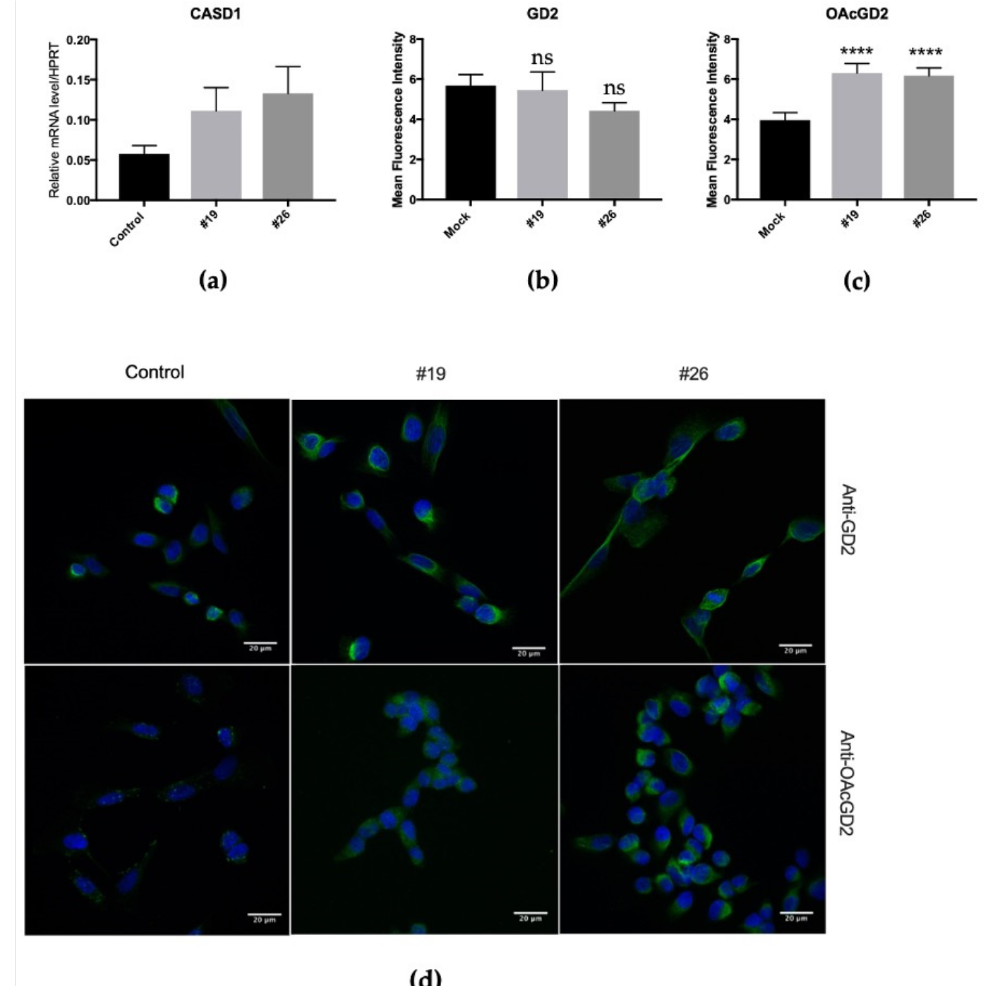
Figure 7. The expression of CASD1 mRNA and quantification of O AcGD2 and GD2 expression in SUM159PT CASD1+ clones. ( a ) RT-qPCR quantification of CASD1 gene expression in stably transfected and control SUM159PT cells ( n = 3). Results were normalized to HPRT mRNA expression. ( b ) Quantification of mean fluorescence intensity of GD2. Statistical difference using unpaired t -test: **** p < 0.0001. ( c ) Quantification of mean fluorescence intensity of O AcGD2. Statistical difference using unpaired t -test: **** p < 0.0001. ( d ) Representative images of the analysis of GD2 and O AcGD2 in selected clones (#19, #26) as compared to control by immunocytochemistry and confocal microscopy ( n = 3). Cells were incubated with anti-GD2 or anti- O AcGD2 mAbs. Gangliosides were visualized using IgG conjugated-Alexa Fluor 488. The nuclei were counterstained with DAPI. All images were taken in the same settings. Scale bar: 25 µ